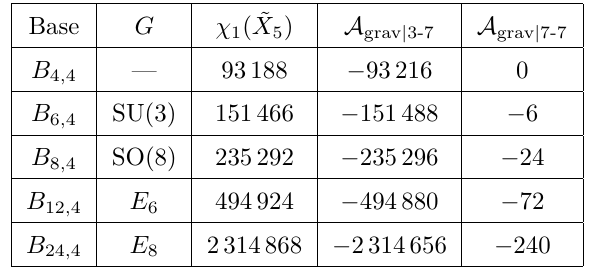
Table 7 . Gravitational anomaly coefficients for the generic elliptic fivefold over the generalized Hirzebruch fourfolds B n, 4